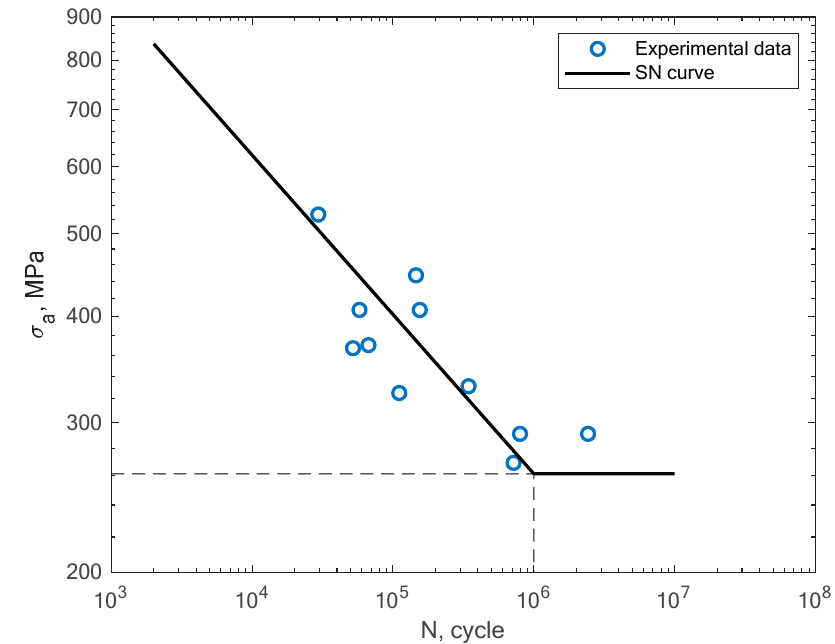
Figure 12. S–N curve for the experimental bending fatigue test results reported by Kostic et al. [2] for the case of heat treatment and no machining.